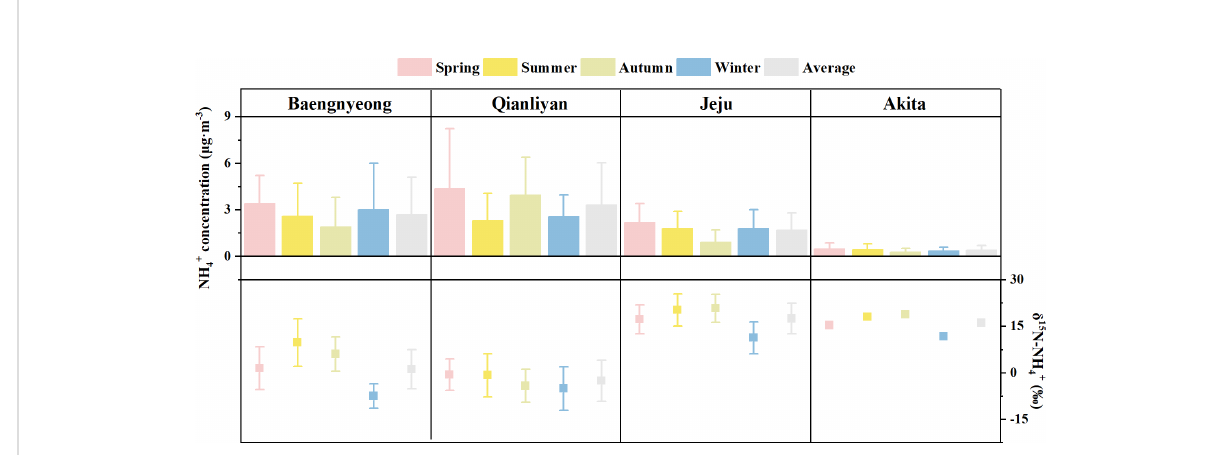
FIGURE 6 The seasonal and annual average (± SD) ammonium concentrations ( m g·m − 3 ) and nitrogen isotopic compositions ( ‰ ) of ammonium over the Yellow sea and the East/Japan sea. Data source: Baengnyeong (Park et al., 2018), Jeju (Kundu et al., 2010), and Akita (Kawashima,